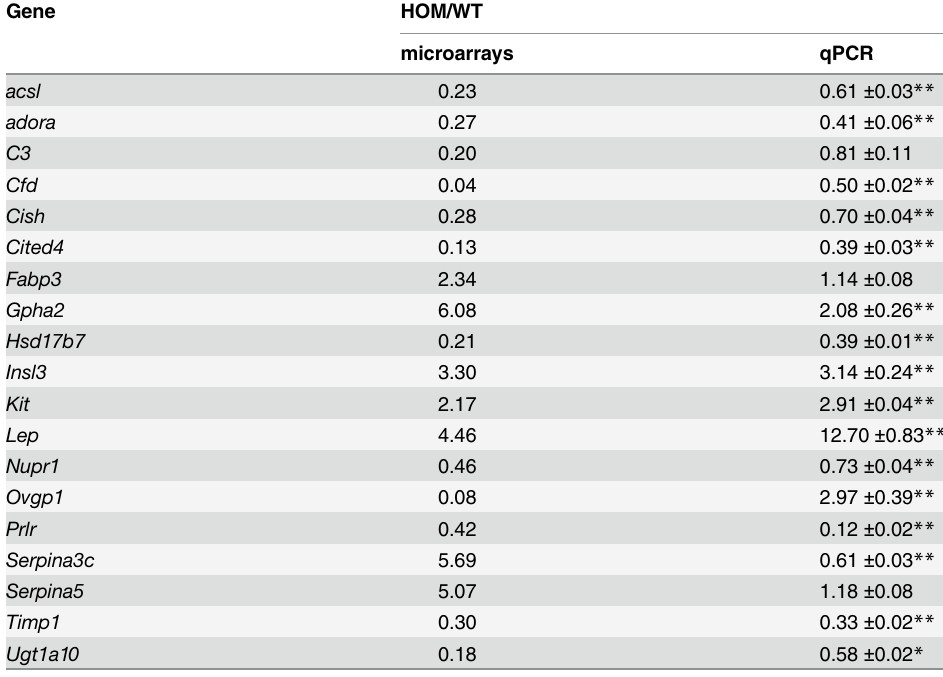
QPCR data indicated as mean ± SD, where * indicates p < 0.05, and ** indicates p <